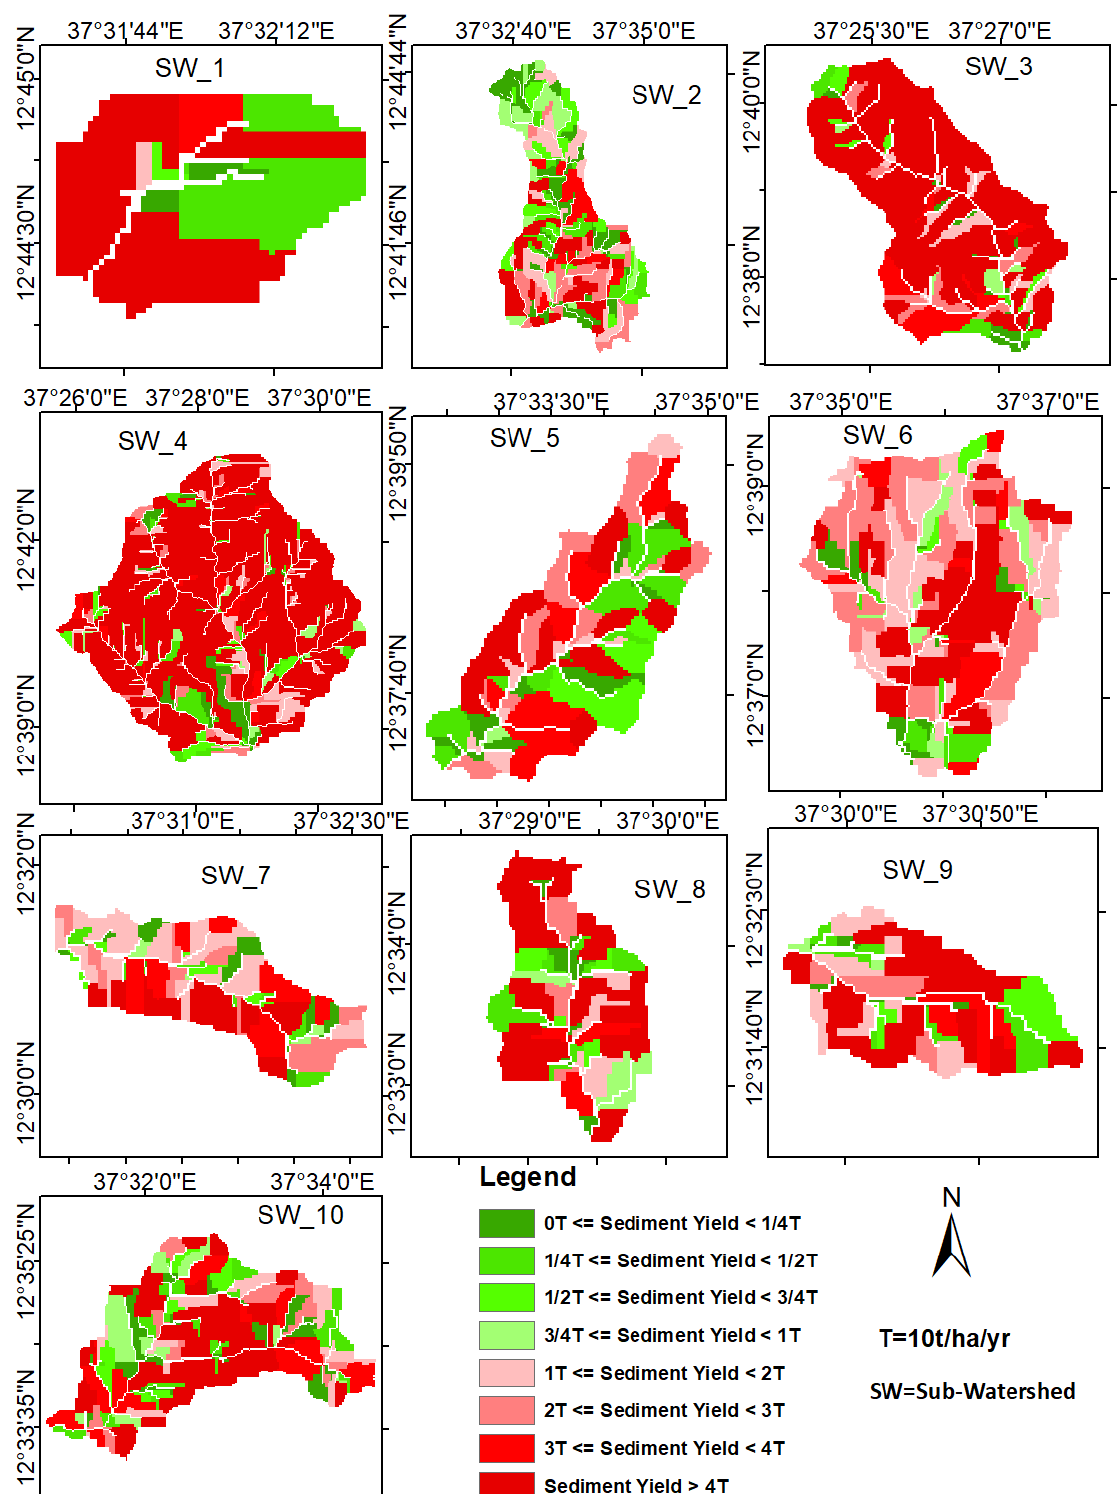
Figure 10. Offsite (watershed) method of the GeoWEPP model simulation for ten selected sub- watersheds (sediment yield map) relative to tolerable (T) value.